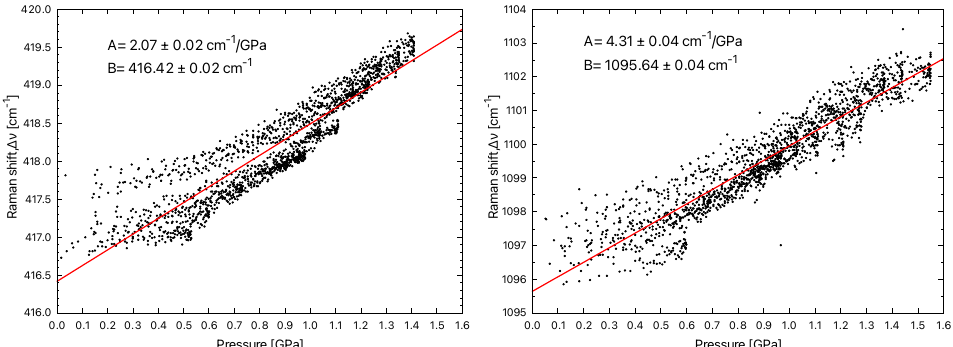
Figure 9. Relationship between contact pressure and Raman shift of the E g mode of alumina at 417 cm − 1 ( left ) and the Q 3 mode of soda–lime glass at 1095 cm − 1 ( right ). A linear fit is used to describe the trend and extract the coefficient. The uncertainty corresponds to asymptotic standard errors. We thus find the value of 2.07 ± 0.02 cm − 1